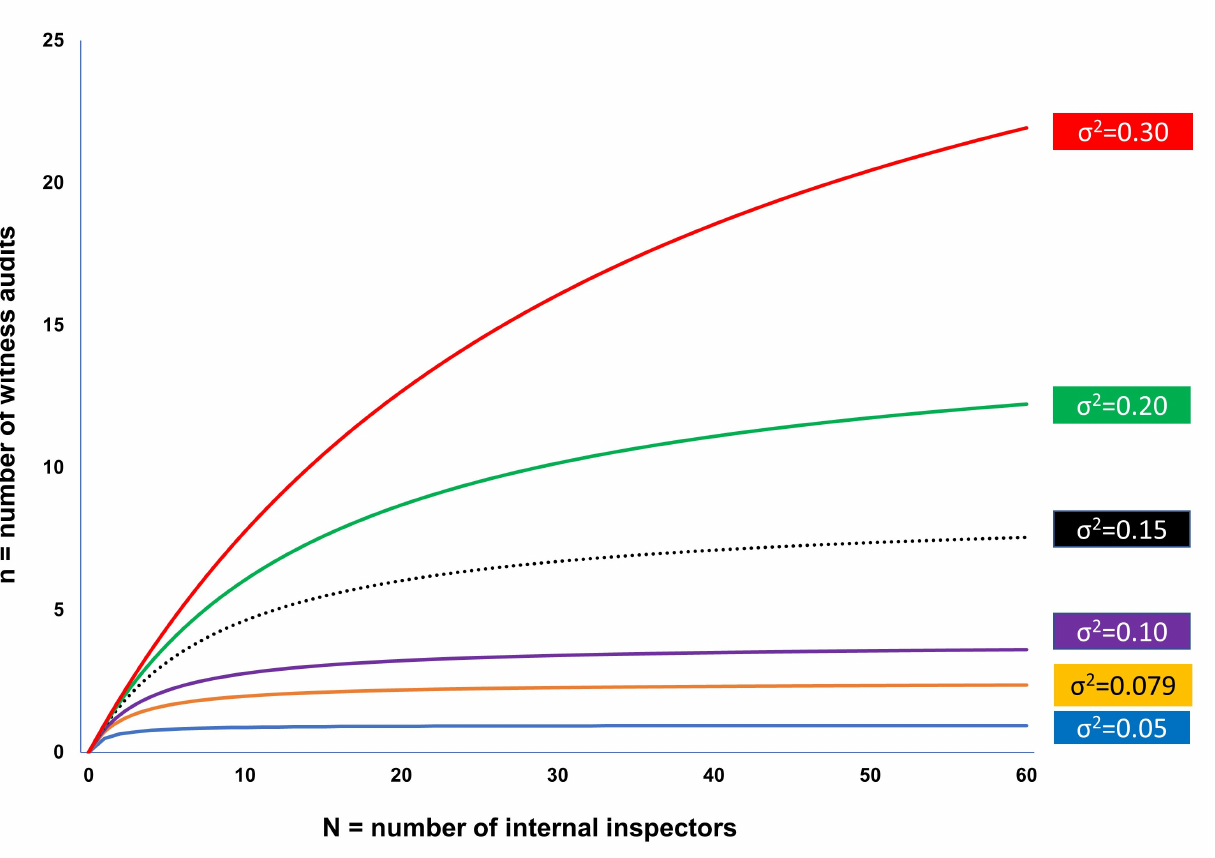
Figure 12. Sample size determination for witness audits with internal inspectors, based on Equation 12, for five different variances σ 2 concerning performance of the internal inspectors. Evaluation of 18 groups from the CERES database yielded a pooled variance σ 2 of 0.079 (orange line). The authors suggest assuming an average variance of 0.15 (black p dotted line).